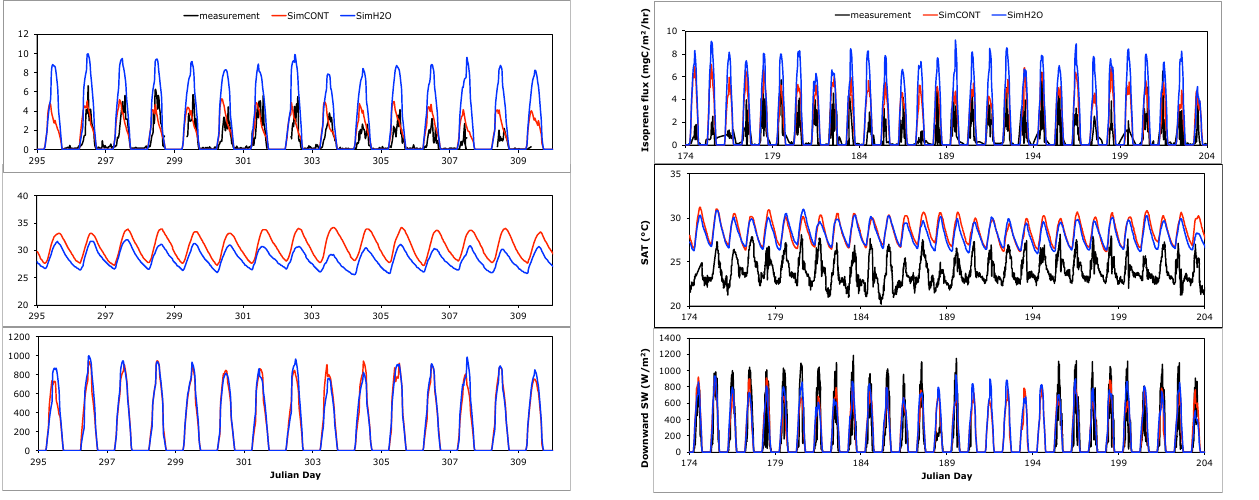
model’s climatological temperature and radiation variables refer to average values over the 2 ◦ × 2.5 ◦ grid cell. SAT is expected to exhibit much higher sub-grid scale variability than downward